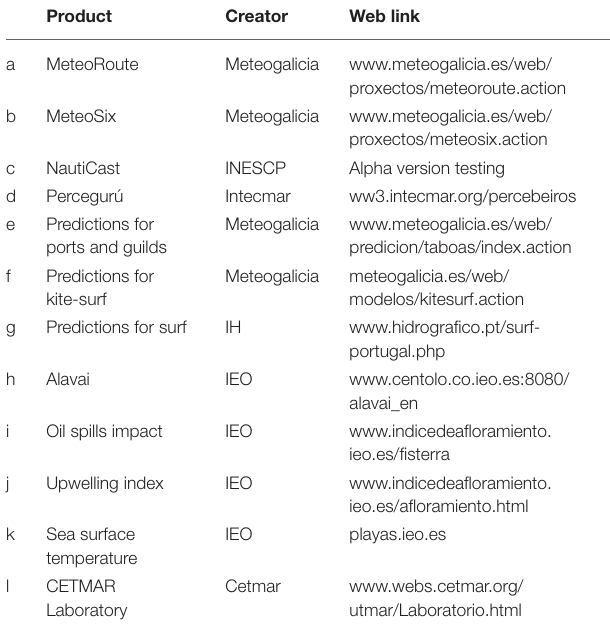
TABLE 2 | List of products for end-users created by the RAIA Observatory partners and their web link.